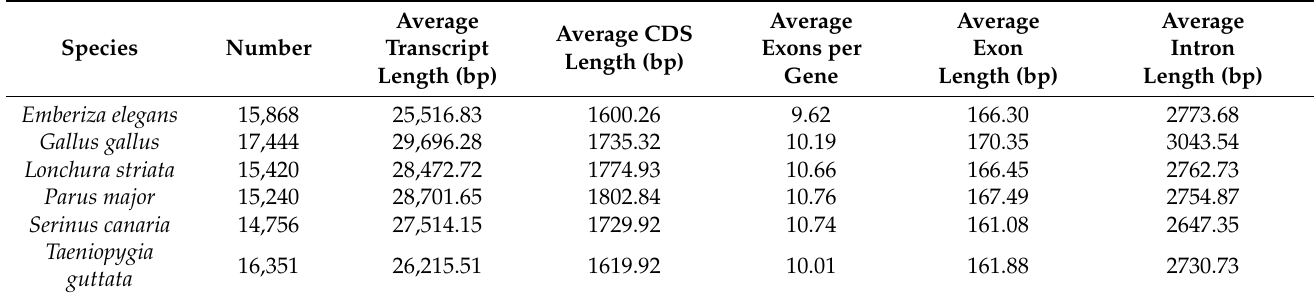
Table 2. Gene structure annotation statistics and other avian genome